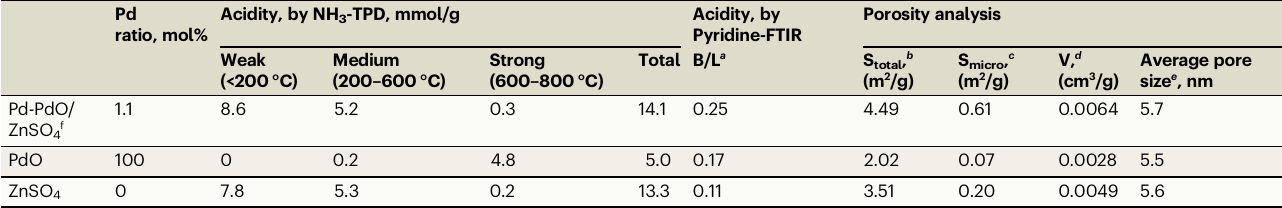
Table 1 | Physiochemical properties of different catalysts Pd Acidity, by NH 3 -TPD, mmol/g Acidity, by ratio, mol%